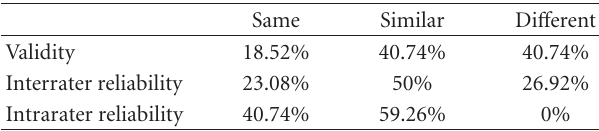
Table 3: Results from the analysis of pathoanatomical diagnosis